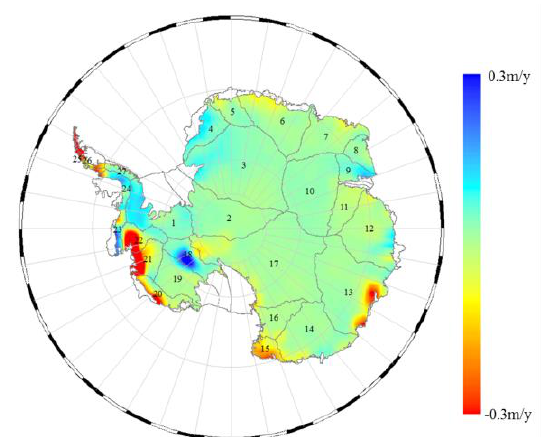
Figure 2. Spatial distribution of elevation change rate of Antarctic ice sheet derived from ICESat data.